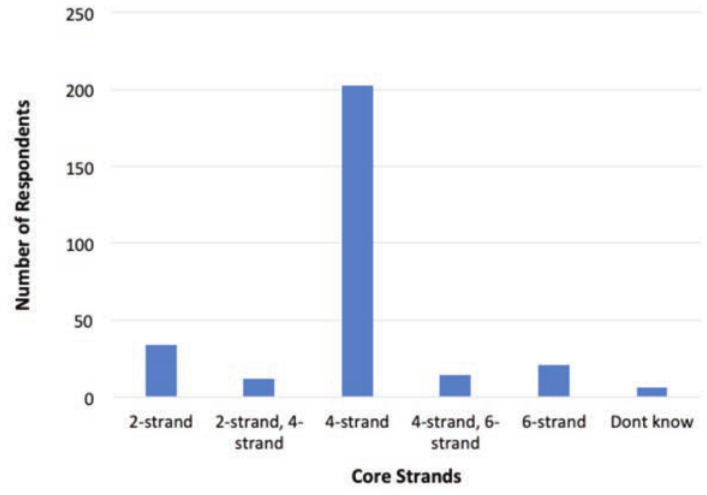
Preferred core strand of respondents in flexor tendon repair. Fig. 2: